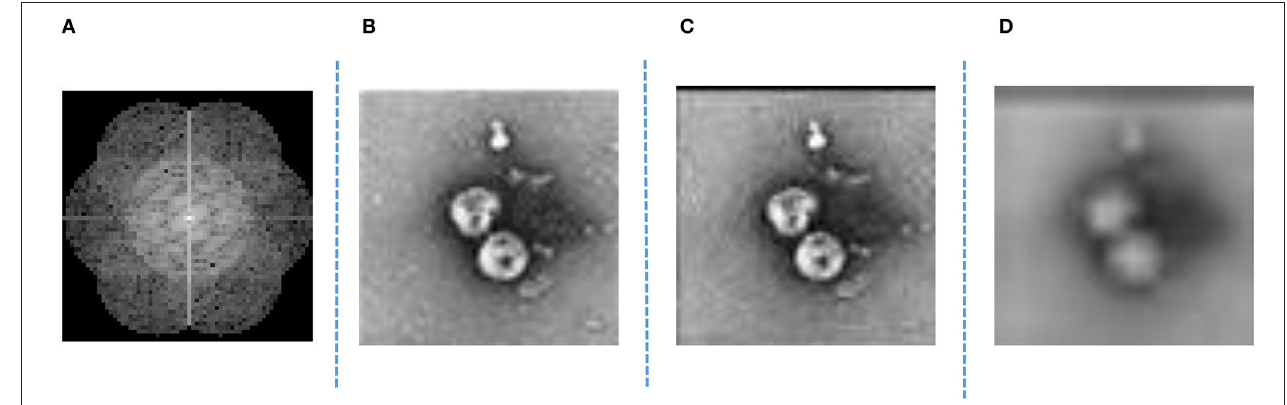
FIGURE 8 | (A) Schematic of imaged wave vector space. (B) Object. (C) Ghost imaging (GI) with plasmonic structure illumination microscopy (PSIM). (D) GI without PSIM.